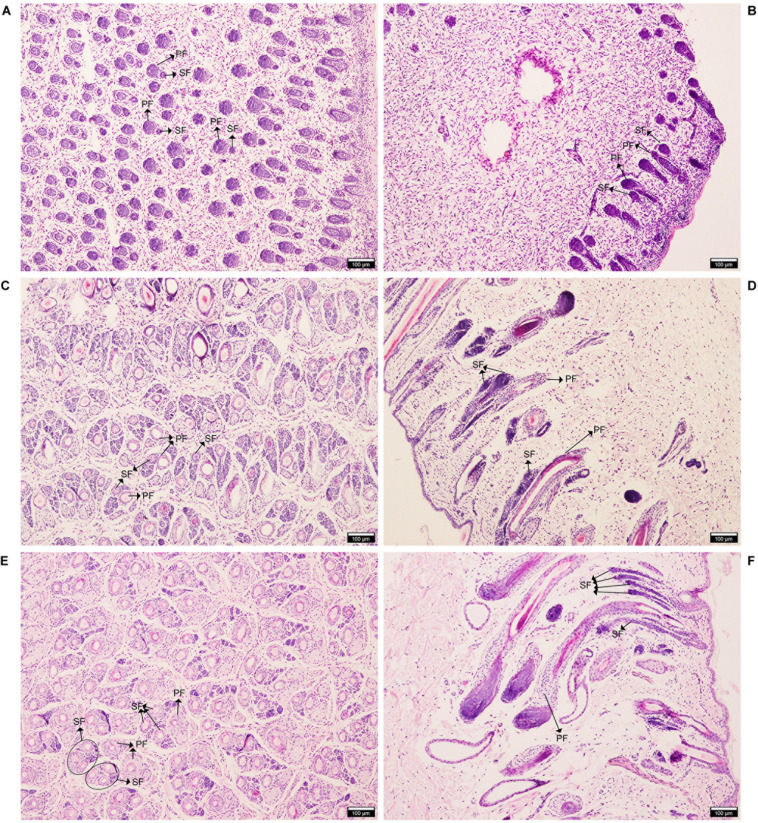
Hematoxylin and eosin (HE) staining of AFWS wool follicles at three developmental stages. Horizontal and longitudinal sections of primary and secondary wool follicles. (A,B) E90d, (C,D) E120d, (E,F) At birth. PF, primary wool follicle; SF, secondary wool follicle.